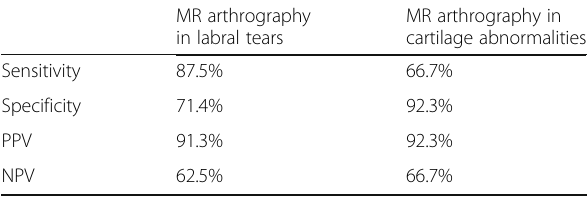
Table 4 Measures of diagnostic performance of MR arthrography (sensitivity, specificity, PPV, and NPV) for detection of labral tears and chondral abnormalities in FAI patients with reference to arthroscope results